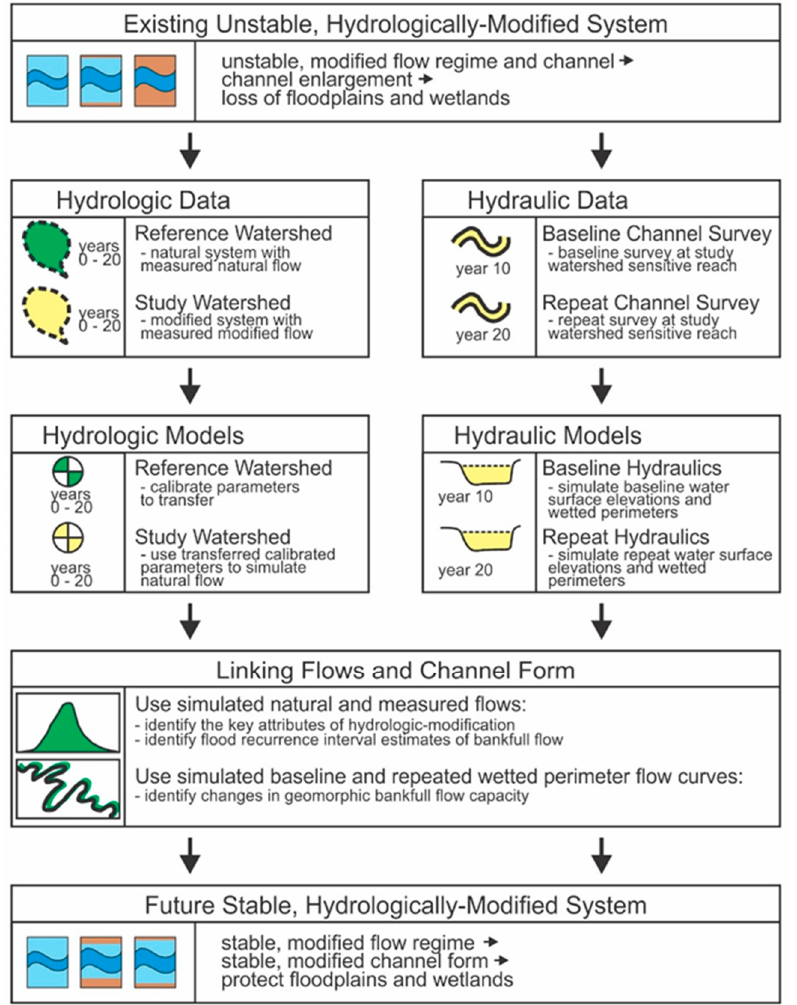
Figure 2. Schematic outlining the method used to assess an existing, unstable, hydrologically modified system. Flow and channel alteration were assessed using a combination of hydrologic and hydraulic data with models to identify a desired, future, stable, hydrologically modified system.